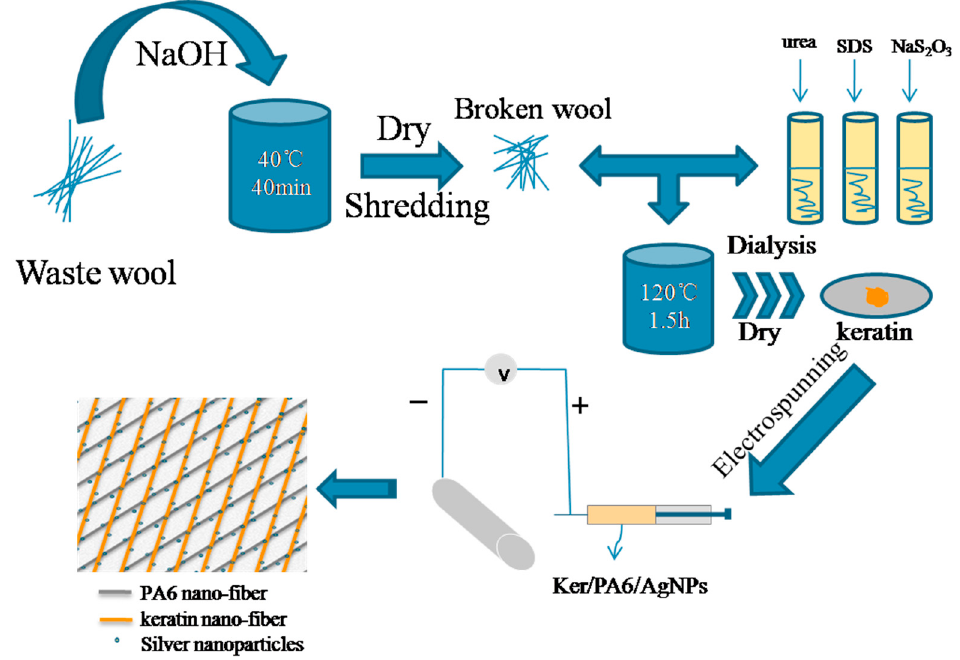
Figure 1. Schematic diagram of the wool keratin extraction and preparation of an electrospun keratin/PA6 air filtration membrane with antimicrobial function.